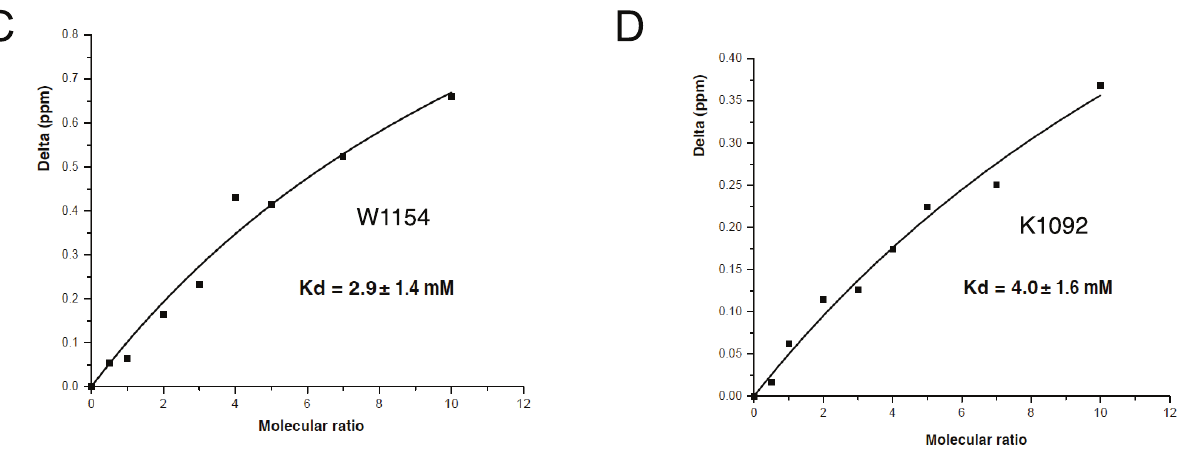
Figure 3. NMR titration confirms that BRPF1 preferentially binds tri-methylated H3K36. (A) Binding affinities of the BRPF1 PWWP domain to different histone peptides. (B)Superposition of 15 N- 1 H HSQC NMR spectra of the BRPF1 PWWP domain in the presence (red) and absence (blue) of H3K79me3 (1:10) and H3K36me3 (1:10) peptides. (C) Binding affinity calculation based on the change in the chemical shifts of W1154 in the 15 N- 1 H BRPF1 resonances upon addition of nonlabeled H3K36me3 peptide. (D) Binding affinity calculation based on the change in the chemical shifts of K1092 in the 15 N- 1 H BRPF1 resonances upon addition of nonlabeled H3K36me3 peptide. The concentration of 15 N BRPF1 in all NMR experiments is 0.2 mM. W1154 and K1092 are two residues from the BRPF1 PWWP